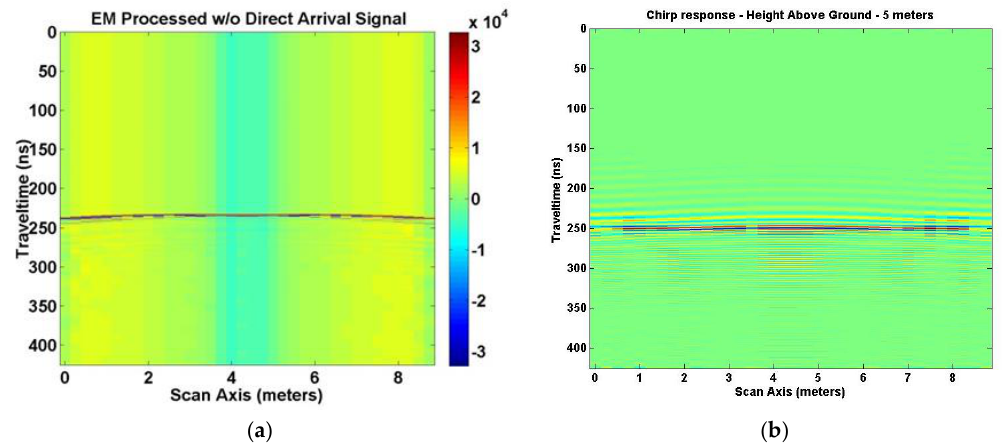
Figure 4. ( a ) Expectation-maximization (EM) sum of frequency signals with direct arrival and ground bounce signals removed [2–5]. ( b ) Chirp excitation signal response with direct arrival and ground bounce signals removed.